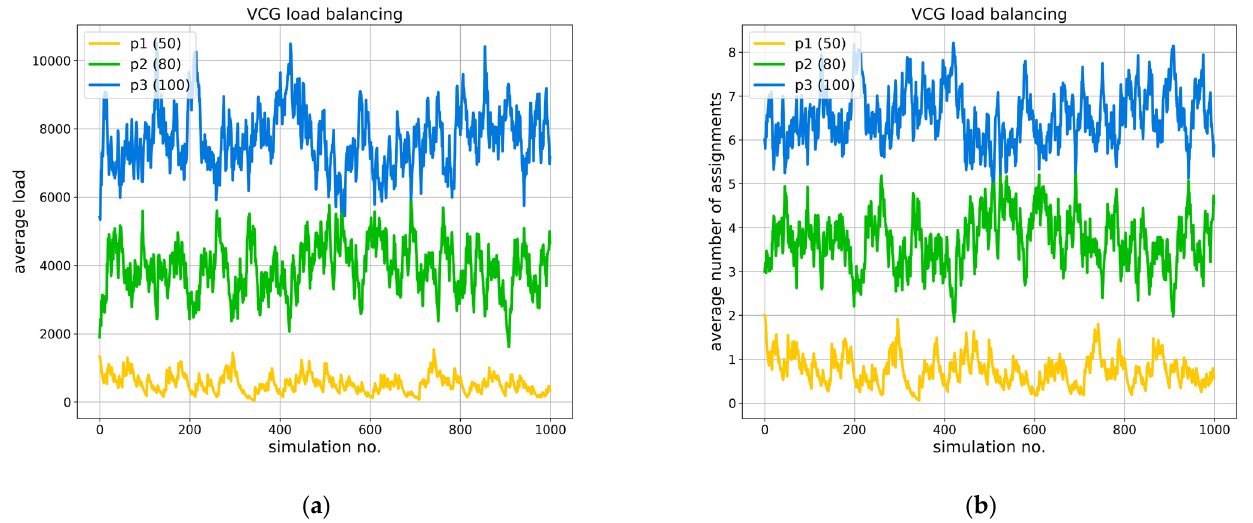
Figure 13. VCG load balancing; ( a ) average reward; ( b ) average number of assignments.